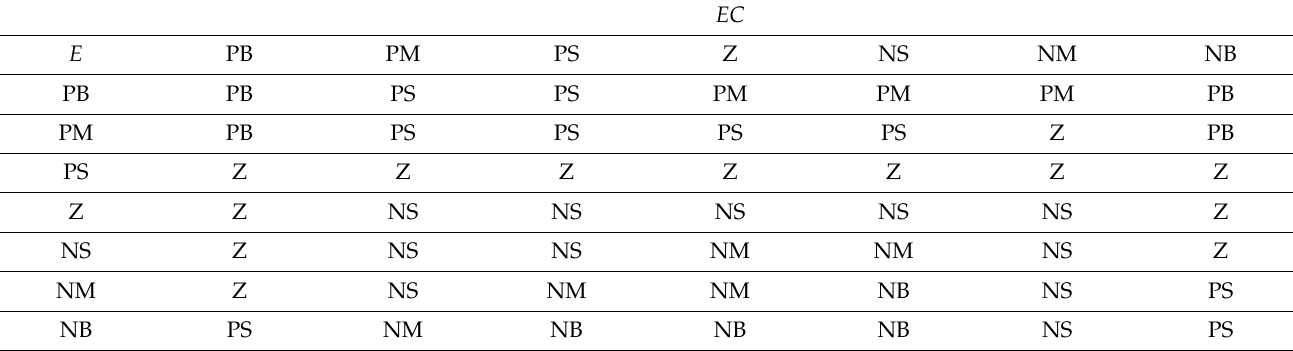
Table 5. Adjustment table of Kd control